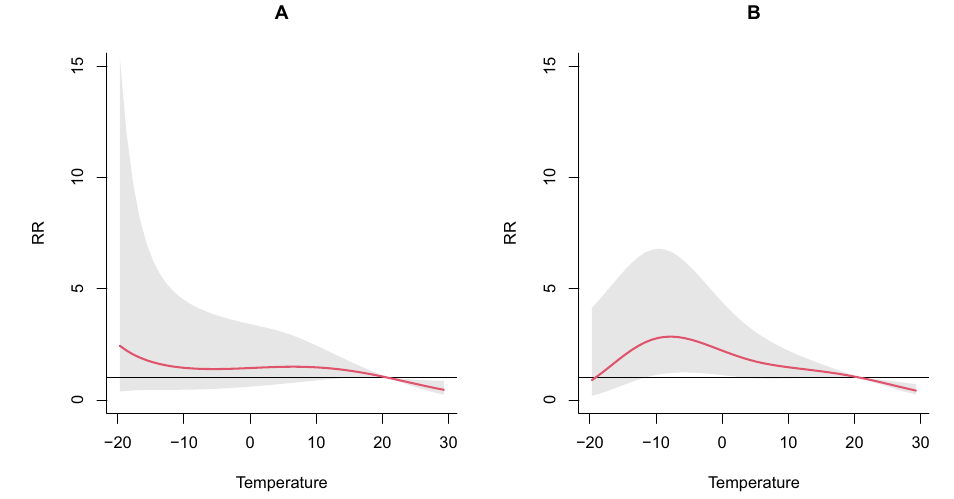
Figure 2. Cumulative effects for exposure–response relationship between temperature and CAP (( A ): < 65 years; ( B ): ≥ 65 years). Note: the hatched area represents the 95% confidence